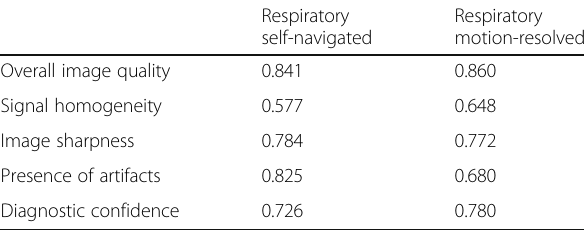
Table 2 Inter-reader agreement in subjective image quality ratings as shown by intra-class correlation coefficient values